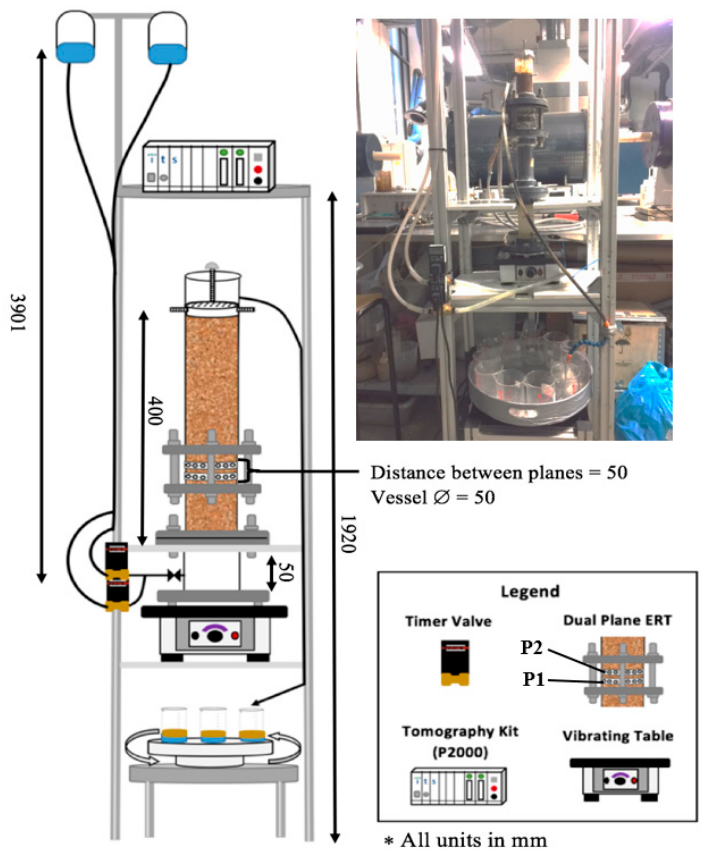
Figure 1. Sand-pack setup for nano-EOR experiments, including a gravity feed and effluent collection system. Where P1 and P2 represent the lower and upper sensor planes, respectively.